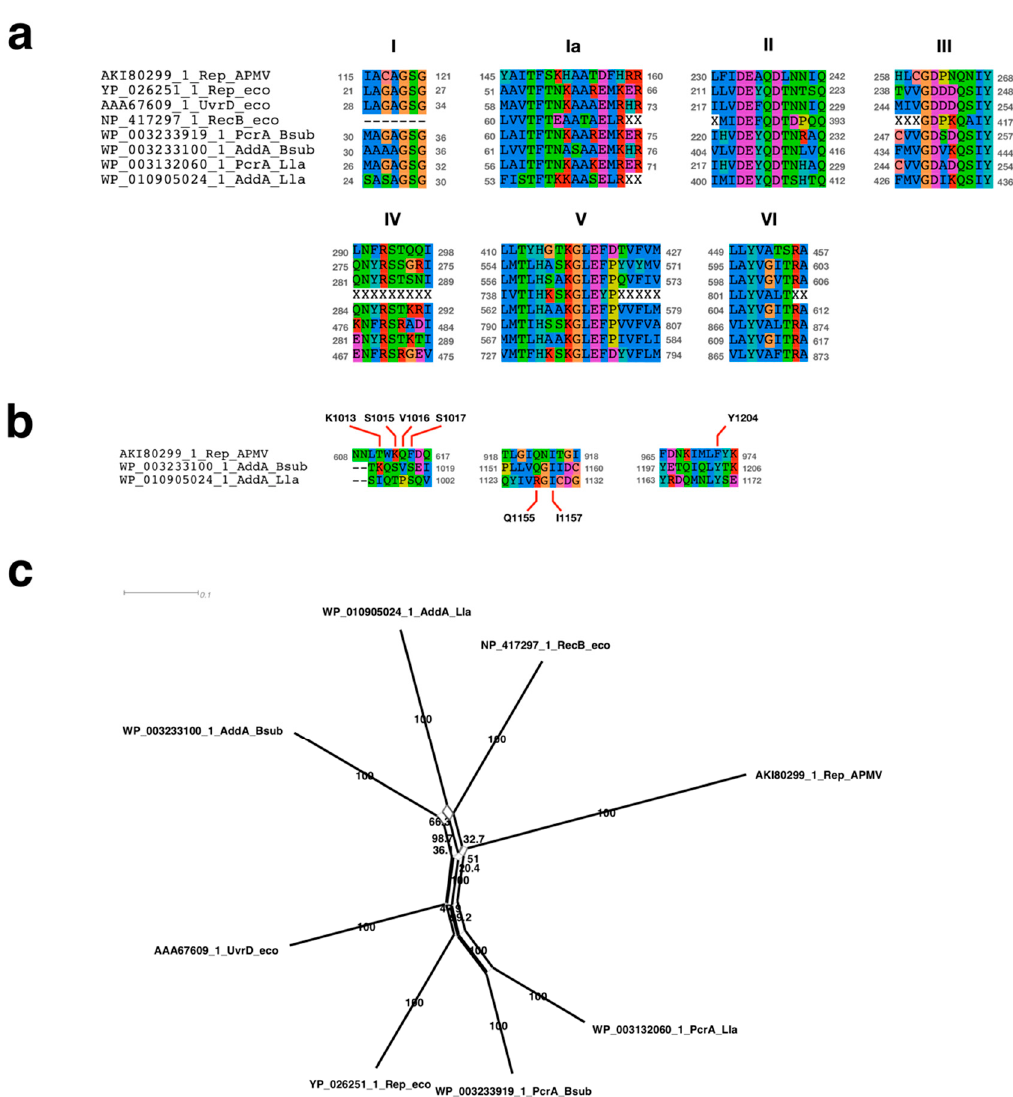
Figure 4. Sequence analyses of UvrD/Rep-like helicase of APMV. ( a ) Sequence alignment of seven conserved regions among APMV and three bacteria. Character “X” on the alignment indicates the residues masked by the prequel program [25]. Accession number and species name are labeled on the left side of the alignments. Grey colored numbers, which are located on both sides of the alignments, indicate the physical positions of each sequence. ( b ) Sequence alignment of chi sequence binding sites. Accession number and species name are labeled on the left side of the alignment. Grey colored numbers, which are located on both sides of the alignments, indicate the physical positions of each sequence. Labels above/under the alignment indicate the amino acids related to the chi sequence binding sites determined using B. subtilis -AddA [37]. ( c ) Neighbor-Net network tree of the UvrD/Rep- like helicase. Accession number and species name corresponding to the sequence alignment are labeled at the end of the branch. Numbers on nearby branches indicate bootstrap test values with 1000 replicates. Scale bar: number of substitutions per site. 3.2.2. Signal Sequence of the Initiation of DNA Replication Subsequently, we sought to find the sequence that was related to the origin of recognition on the probable ori region. To accomplish this, we first calculated the quartet nucleotide composition ratio of the ori -containing region per total genome (Figure 5). For details of the calculation of the ratio, see Materials and Methods. The four types of sequences that had a ratio greater than 2 contained 75 –